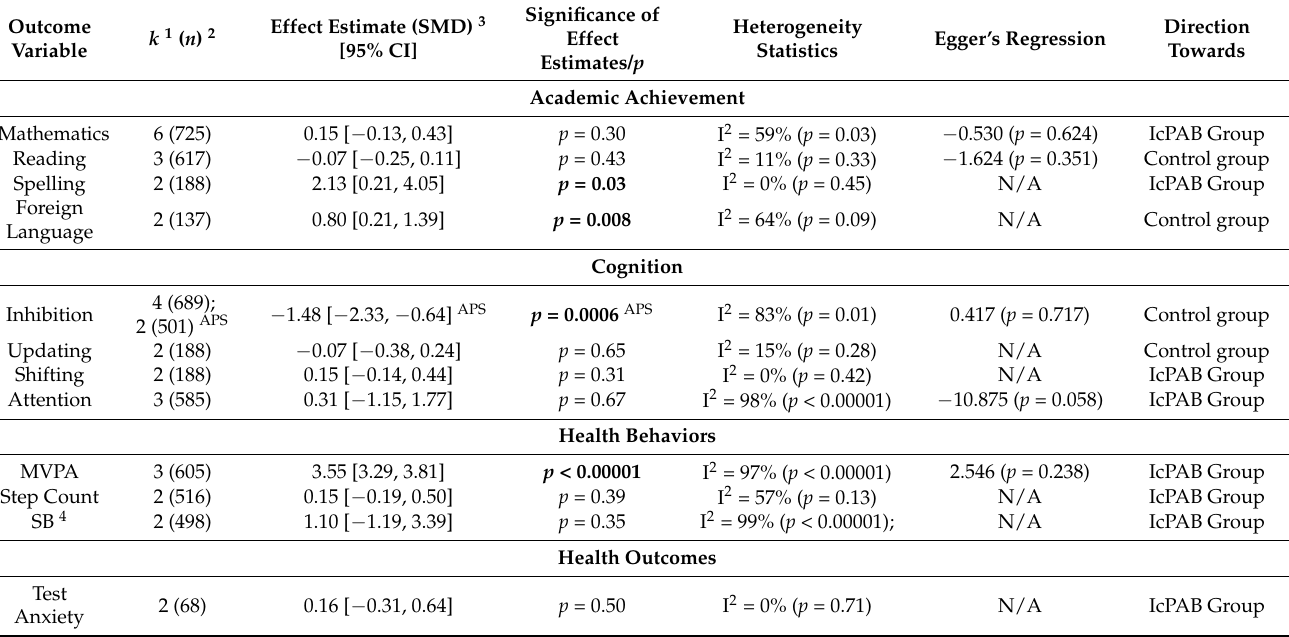
Table 4. Meta-analysis: IcPAB’s effects on the academic achievement, cognition, health behaviors, and health